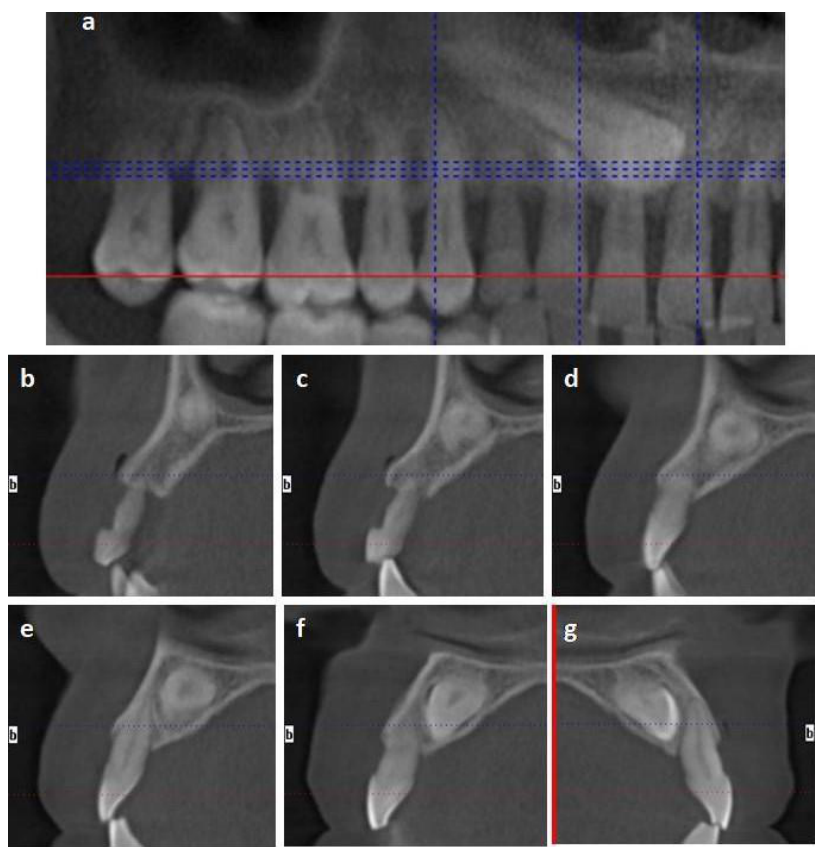
Figure 1. Case 1 tomography-scan (CT-Scan) images. ( a ) Image analogous to panoramic radiography of the first quadrant. ( b – g ) Sagittal sections show the impacted canine and its relationship with the adjacent teeth: Temporal canine 53 ( b , c ); tooth 12 ( d , e ); tooth 11 ( f ); and tooth 21 ( g ).